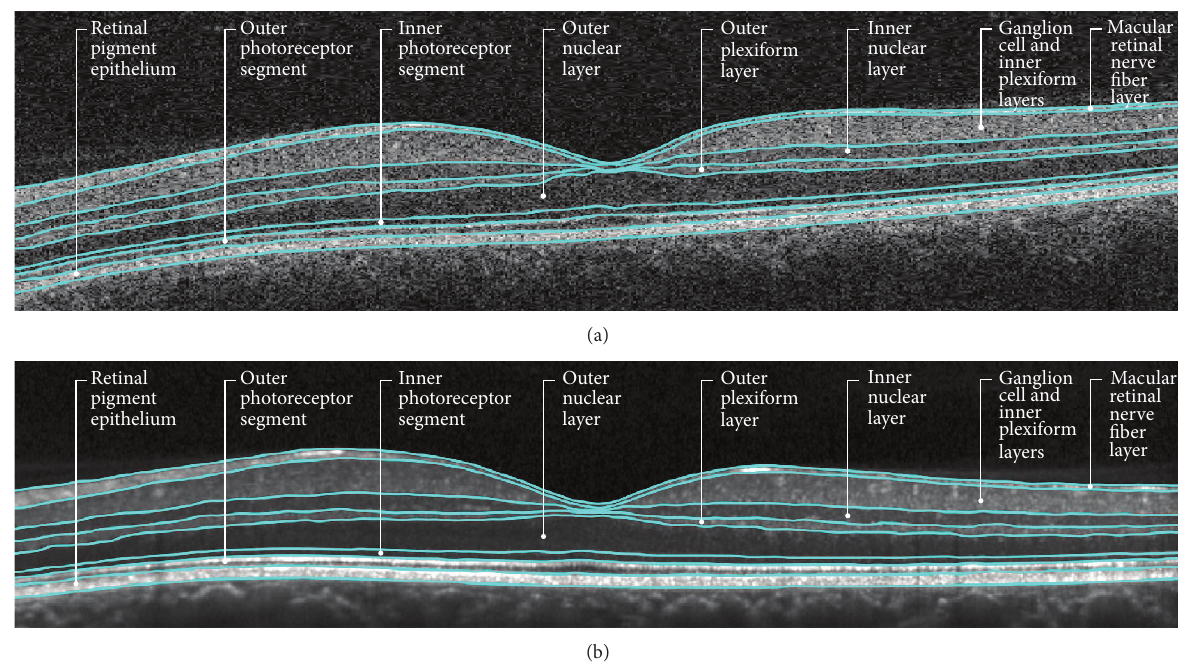
Figure 1: Depiction of retinal segmentation of concomitant Cirrus HD-OCT and Spectralis scans. This figure demonstrates the retinal layer segmentation in corresponding scans from a patient with MS, acquired on Cirrus HD-OCT (a) and Spectralis (b) scanners. The different retinal layers segmented by the automated segmentation algorithm have been